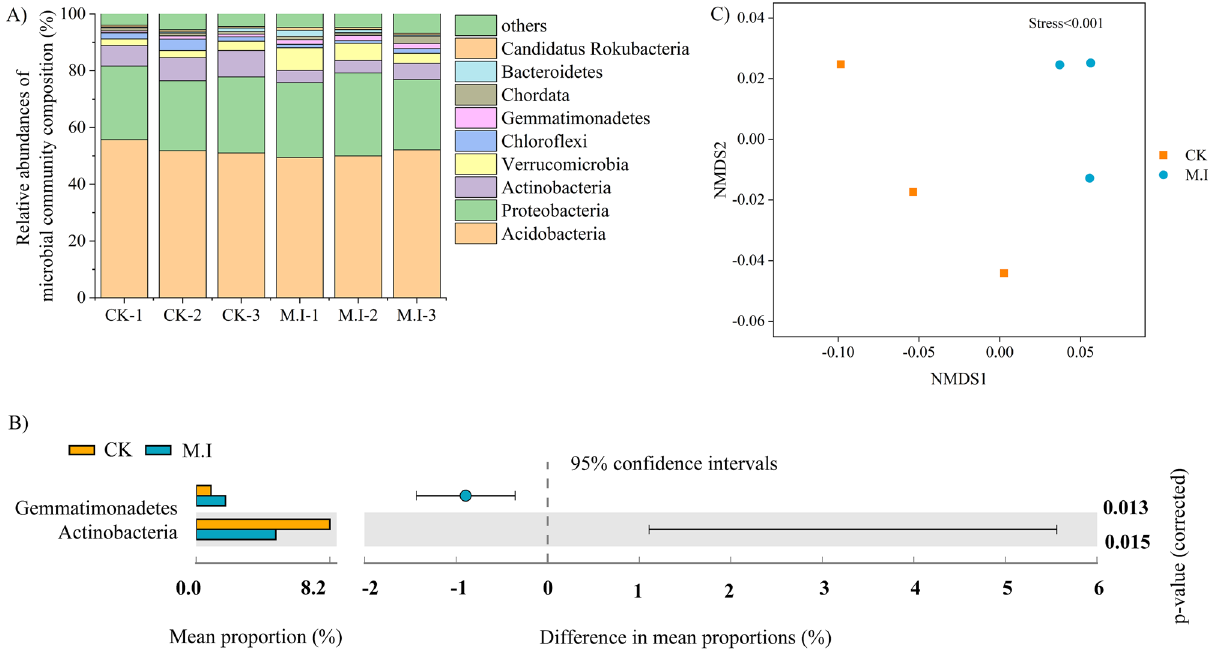
Figure 2. Microbial community composition and structure in soil of the pristine forest forests and M. micrantha -invaded forest. ( A ) Relative abundances at the phylum level in soil. ( B ) Differential species at the phylum level in soil. ( C ) The non-metric multidimensional scaling (NMDS) plot of microbial structures.